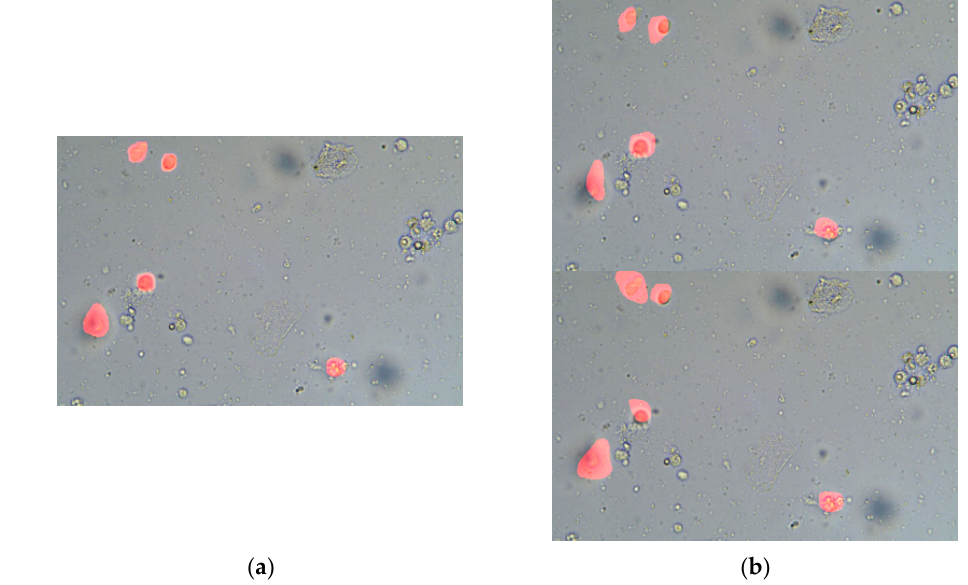
Figure 4. Examples of the generated random rough detection results. For convenience of display, we have used red to mark the TV regions on the original image. ( a ) Ground truth of TV; ( b ) two examples of the generated rough detection result.